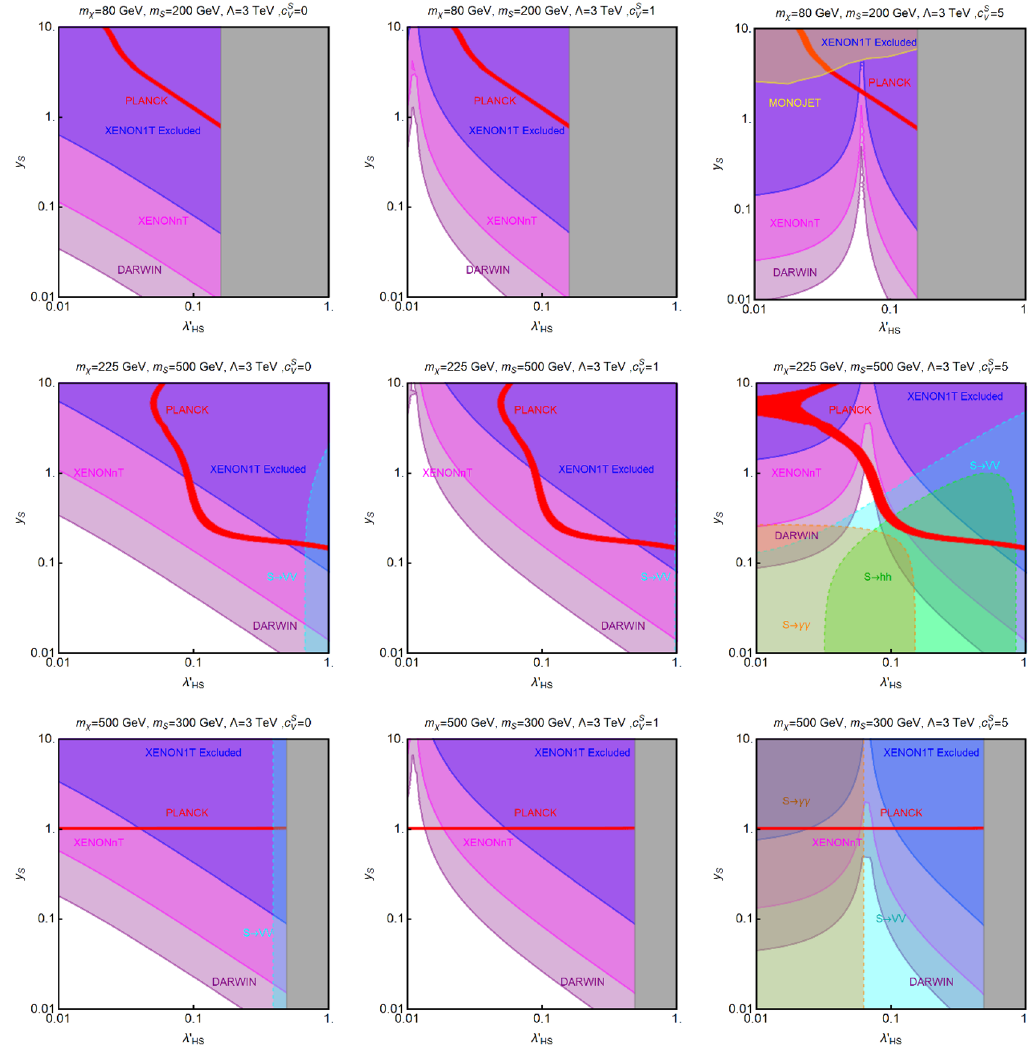
Figure 4 . Summary of constraints for the mixing portal completed with D = 5 interactions between the scalar mediator and the gauge bosons. The results are shown in the (cid:21) 0 (cid:0) y S plane HS for c S = 0 ; 1 ; 5 and three di(cid:11)erent mass assignations as indicated in the individual panels. The V red contours correspond to the correct relic density while the blue regions are excluded by limits from DD, as given by XENON1T, and the magenta and purple regions represent the projected sensitivities of XENONnT and DARWIN. The excluded regions from Higgs signal strengths are depicted in gray. Green, cyan, and orange regions are excluded by collider searches for resonances decaying into SM Higgs pairs, massive gauge bosons, and photons, respectively. The latter bounds rely on the assumption of a common parameter c S for the couplings with gauge bosons and could V be lifted by setting c S ; c S (cid:28) c S . The yellow region in the top right panel is excluded by monojet B W G searches.